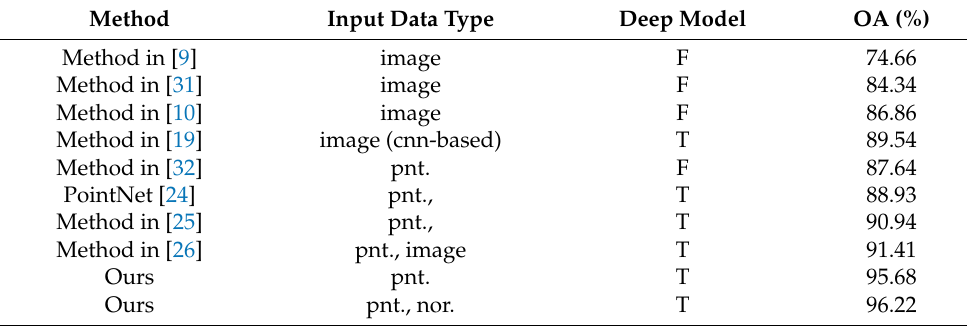
Table 4. Comparison with the methods proposed in the